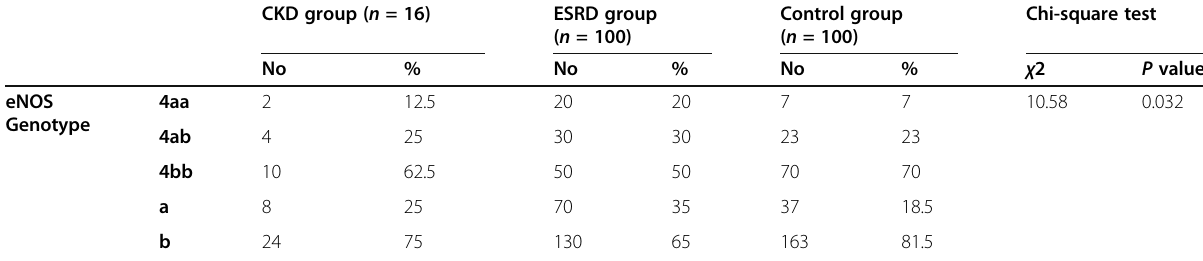
Table 4 Distribution of eNOS intron 4 polymorphism in cases and